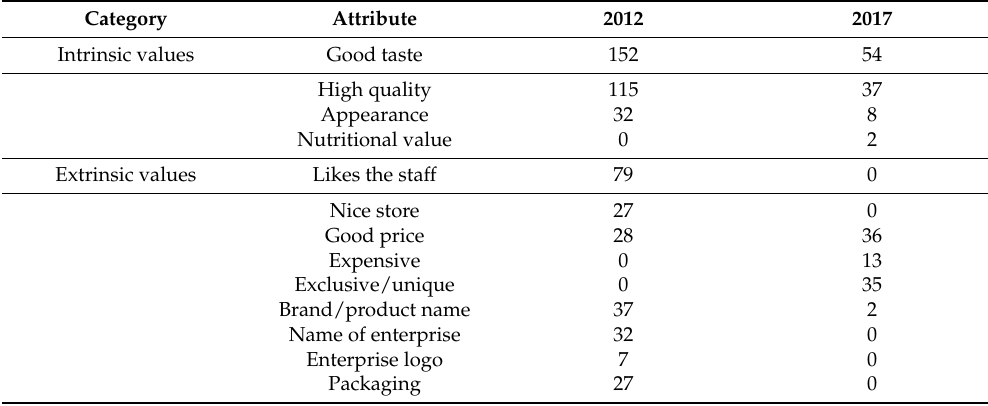
Table 2. The intrinsic and extrinsic attributes 1